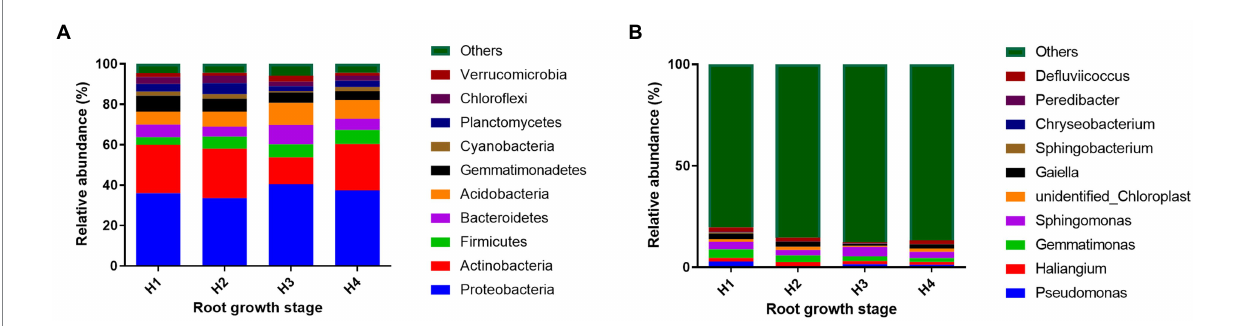
FIGURE 3 Soil bacterial community structure and relative abundance of taxa at the phylum (A) and genus (B) levels at root growth stages H1–4. H1–4, root growth stages of mixed forage: January 4 (H1), March 14 (H2), April 21 (H3), and May 19 (H4).